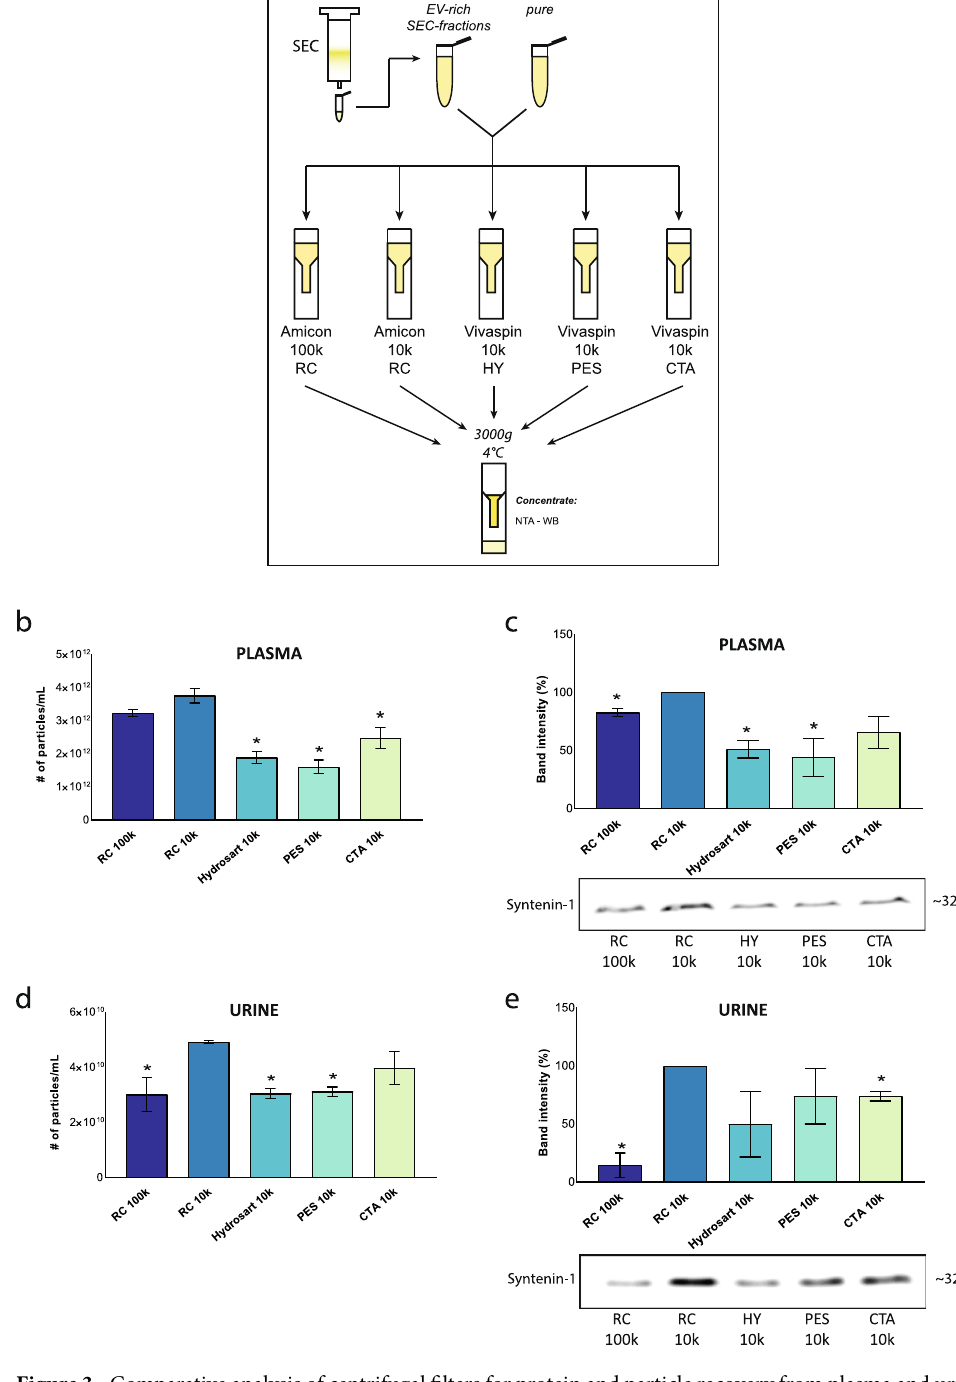
Figure 3. Comparative analysis of centrifugal filters for protein and particle recovery from plasma and urine. ( a ) Blood plasma was loaded on SEC column and EV-rich fractions were concentrated using five different centrifugal filters. Urine was concentrated using the same type of filters. ( b ) Nanoparticle Tracking Analysis (n = 2, * p < 0.05) and ( c ) Western blot analysis for syntenin-1 was performed on concentrated EV-rich SEC- fractions from plasma (n = 2, * p < 0.04). Western blot analysis was quantified using RC 10k as reference. ( d ) Concentrated urine was analyzed by Nanoparticle tracking analysis (n = 2, * p < 0.05) and ( e ) Western blot analysis for syntenin-1 (n = 2, * p < 0.02). Western blot analysis was quantified using RC 10k as reference in ( c , e ). Mean values + SD are indicated. Significant differences were calculated using Student’s t-test with RC 10k as reference. Original immunostaining results are shown in Supplementary Fig. 10. Abbreviations: SEC: size-exclusion chromatography. EV: extracellular vesicle. RC: regenerated cellulose. HY: Hydrosart. PES: polyethersulfone. CTA: cellulose triacetate. WB: Western blot. NTA: Nanoparticle tracking analysis. PCM: protein concentration